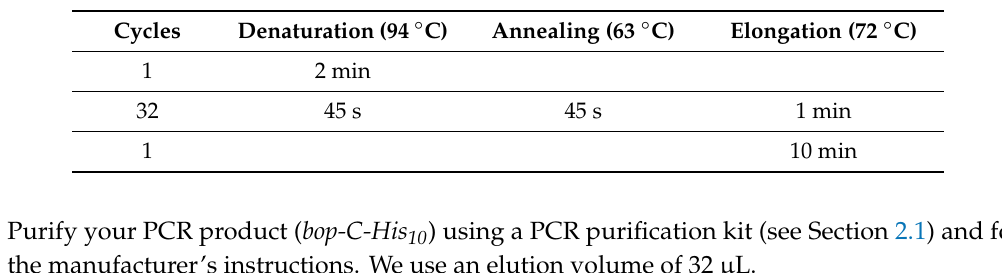
Table 2. PCR program for site-directed mutagenesis of the bop gene.